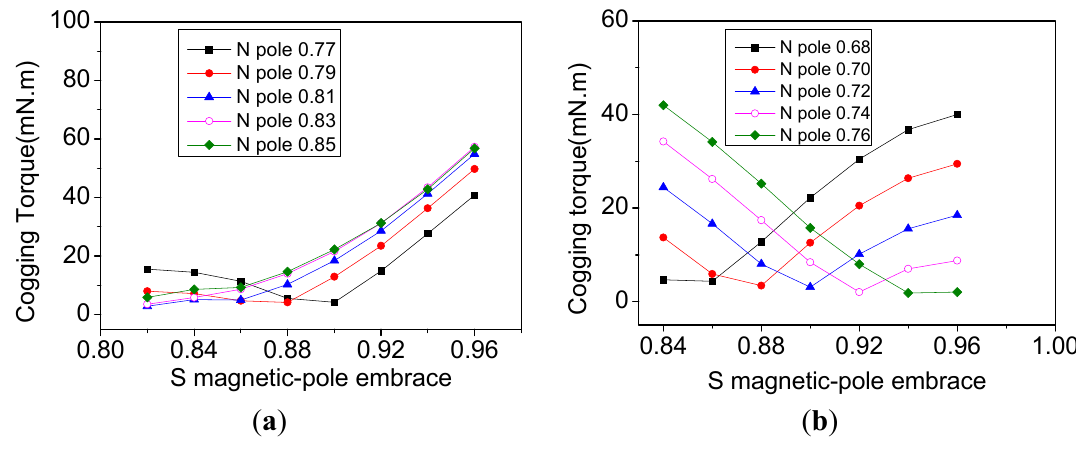
Figure 6. N poles and S poles of the machine with different magnetic-pole embrace values.